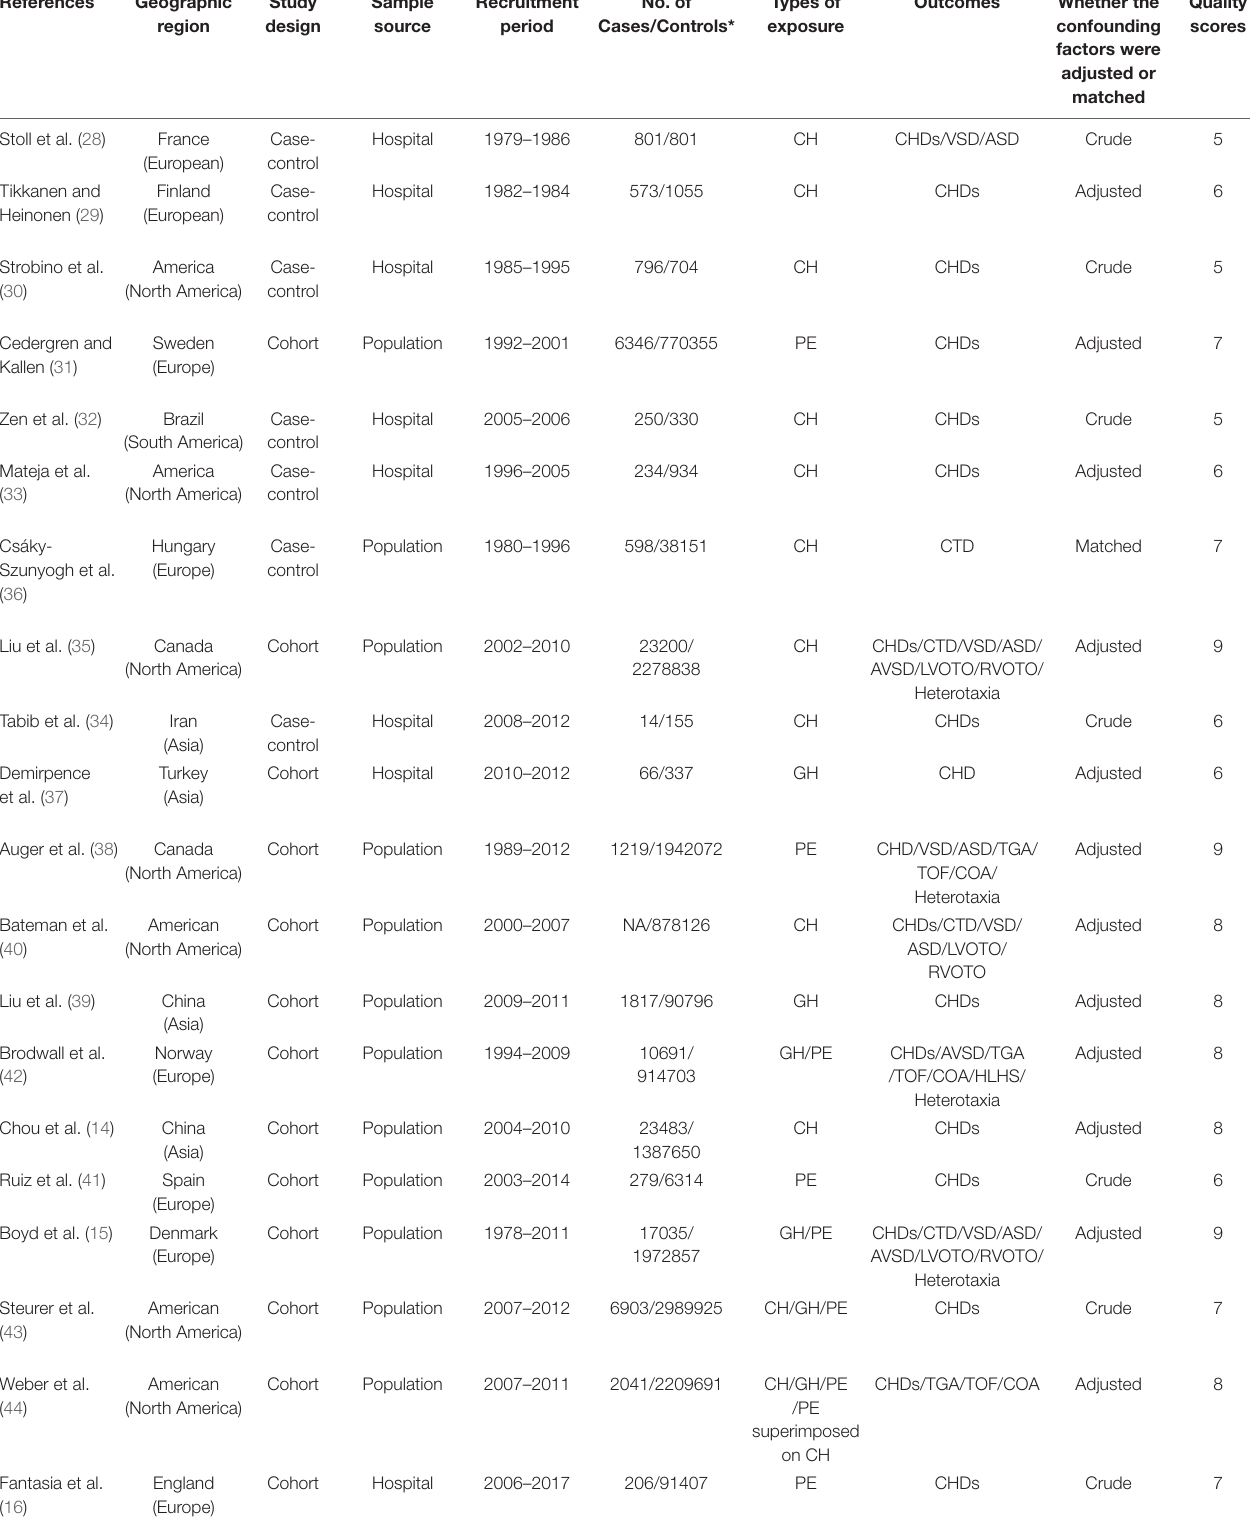
TABLE 1 | Characteristic of studies of maternal HDP exposure and risk of congenital heart defects in